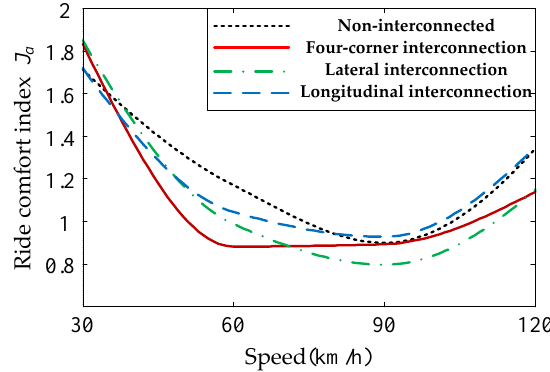
Figure 4. Ride comfort index J a under the straight condition.